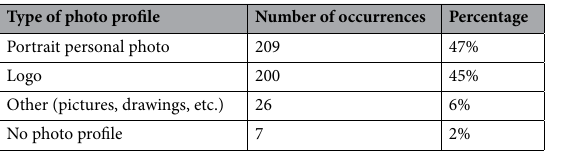
Table 2. Overview of the type of profiles included in the HF Twitter list observing their photo